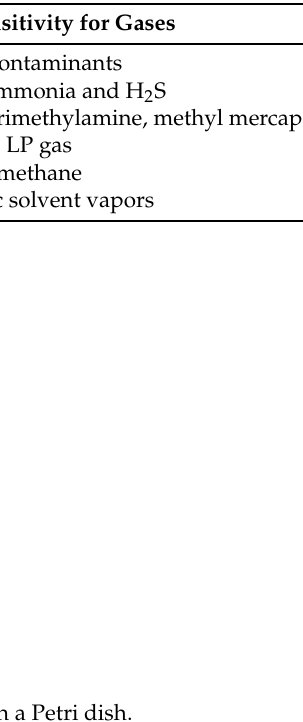
Table 1. List of sensors used in the e-nose device and most sensitive molecules.